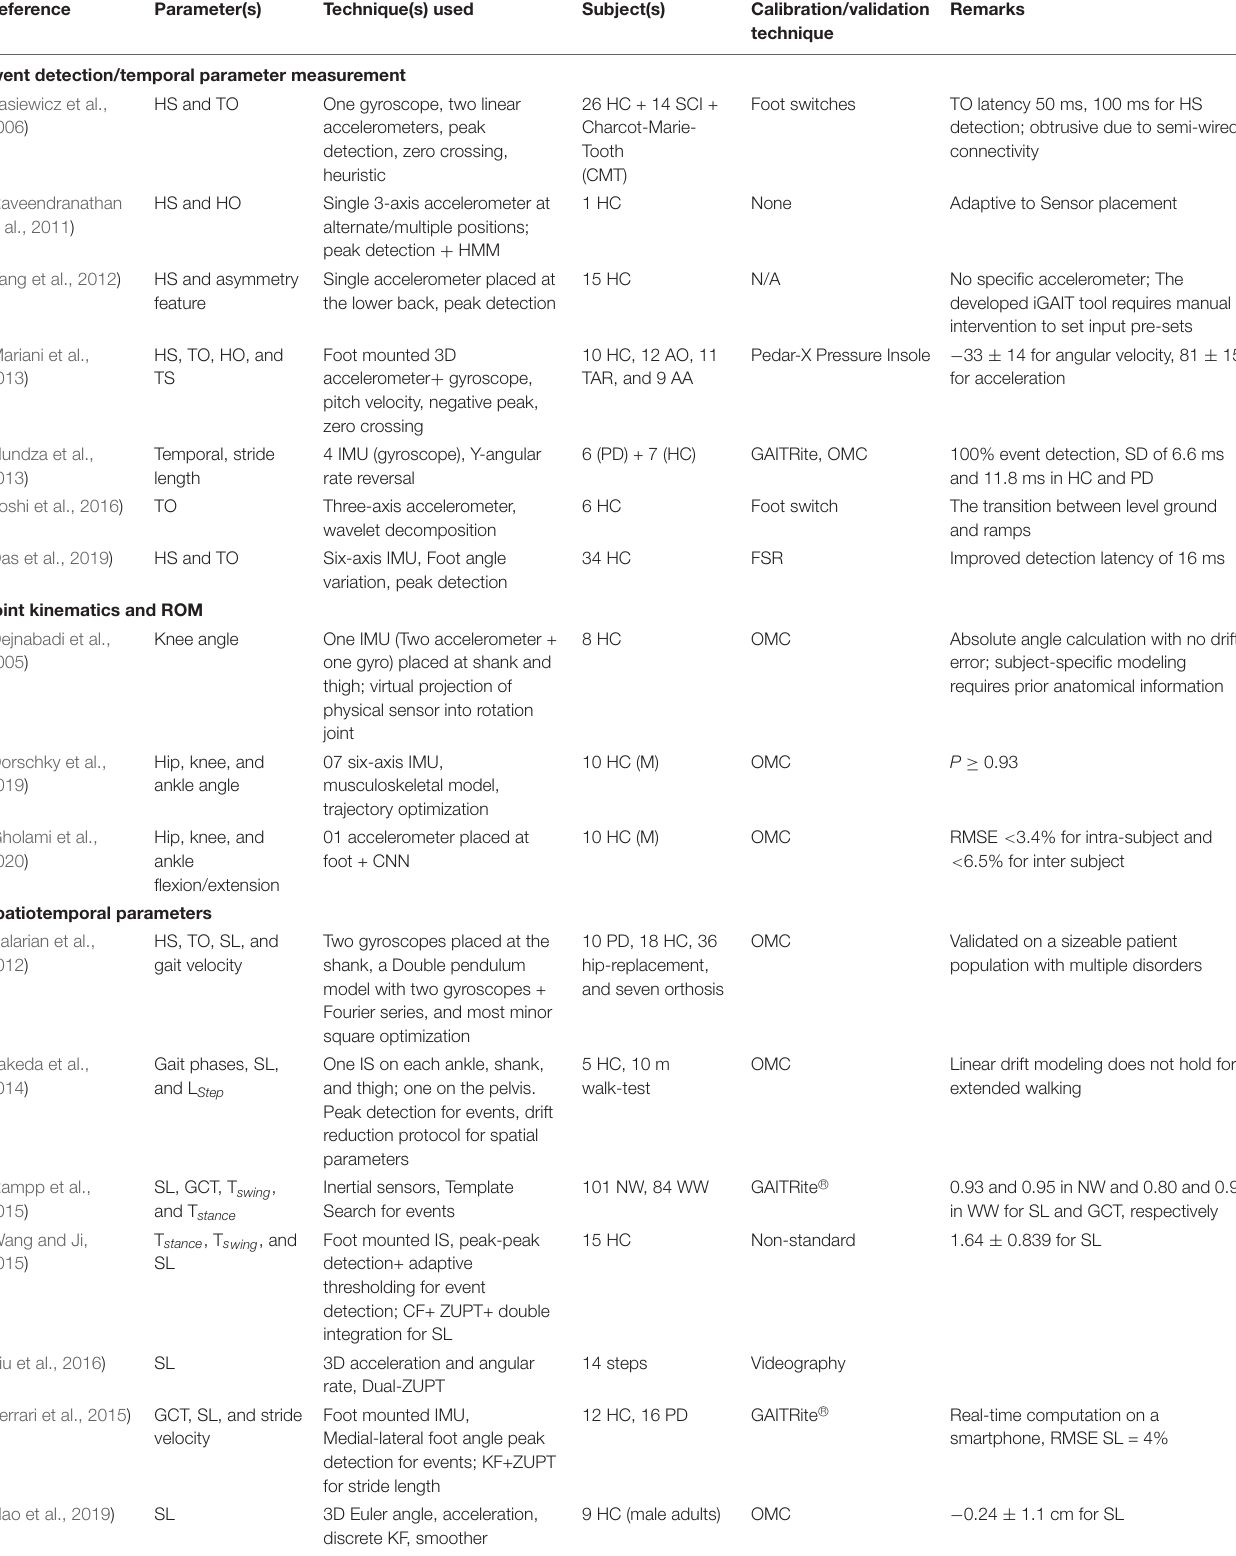
TABLE 2 | Inertial sensor-based gait and balance analysis: from the prospect of event detection, spatiotemporal parameter estimation, joint ROM, and balance analysis.